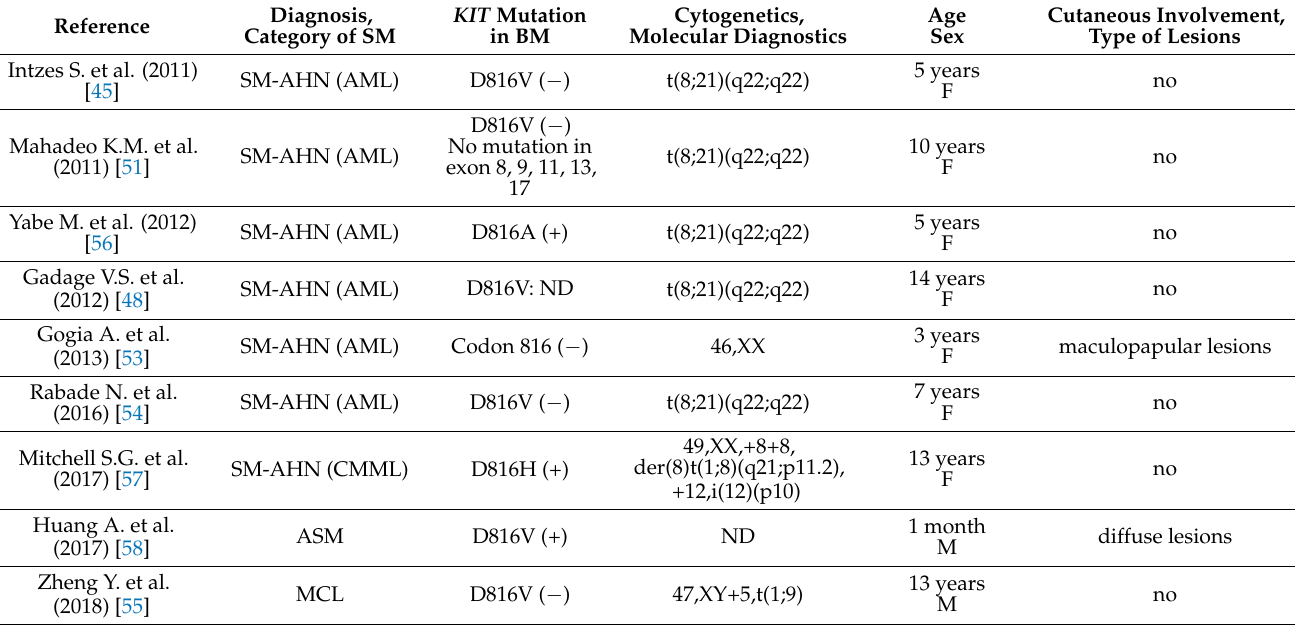
Table 1. Advanced SM in children: case studies with molecular diagnostics published in the last decade. KIT Mutation Diagnosis, Cytogenetics, Reference Category of SM in BM Molecular